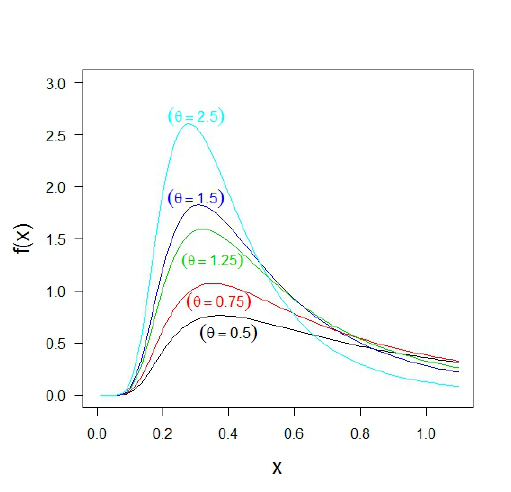
Figure 3 – Density plot of IEGD for different values of θ